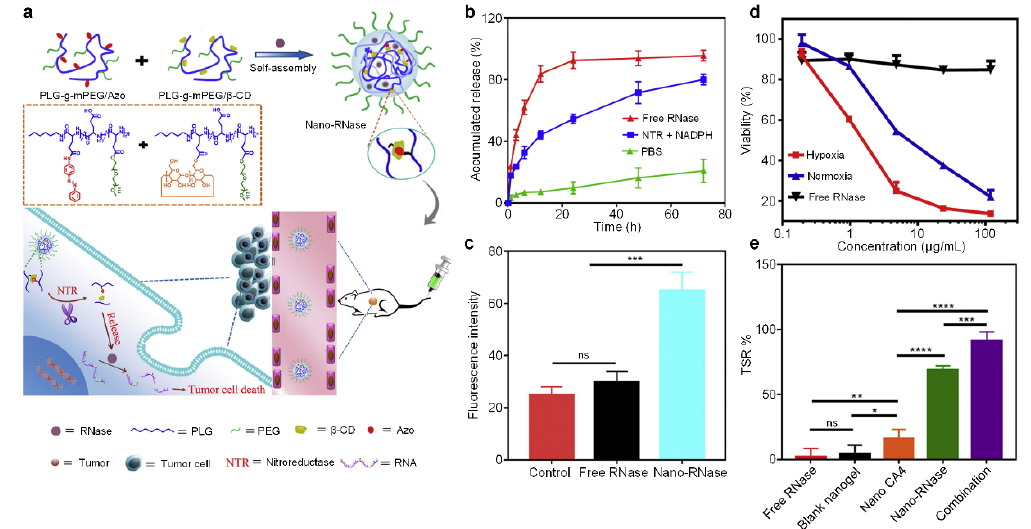
Figure 5. ( a ) Schematic illustration of preparation of Nano-RNase for hypoxia-responsive gene delivery. ( b ) In vitro RNase release profiles of nano-RNase under different condition. ( c ) Flow cytometry quantitative analysis of 4T1 cells incubated with free RNase or nano-RNase. ( d ) Cell viability of 4T1 cells incubated with different concentrations of Nano-RNase or free RNase under hypoxia or normoxia. ( e ) In vivo tumor suppression rate (TSR) of different treatments. * p < 0.05; ** p < 0.01; *** p < 0.001; **** p < 0.0001, ns represents no significant differences. Adapted from [61]. Copyright © 2020